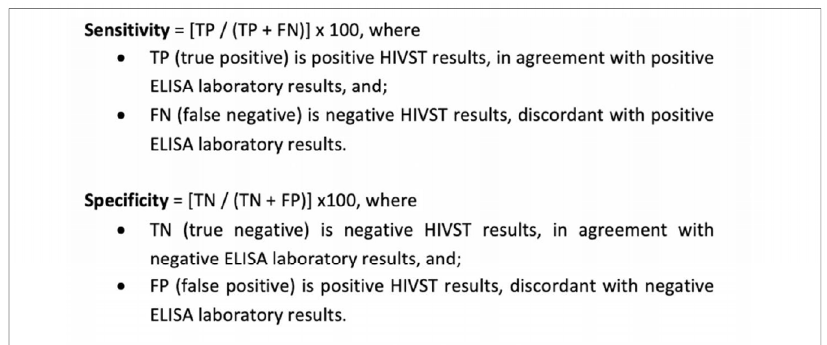
Figure 4. Sensitivity and specificity calculations [16].